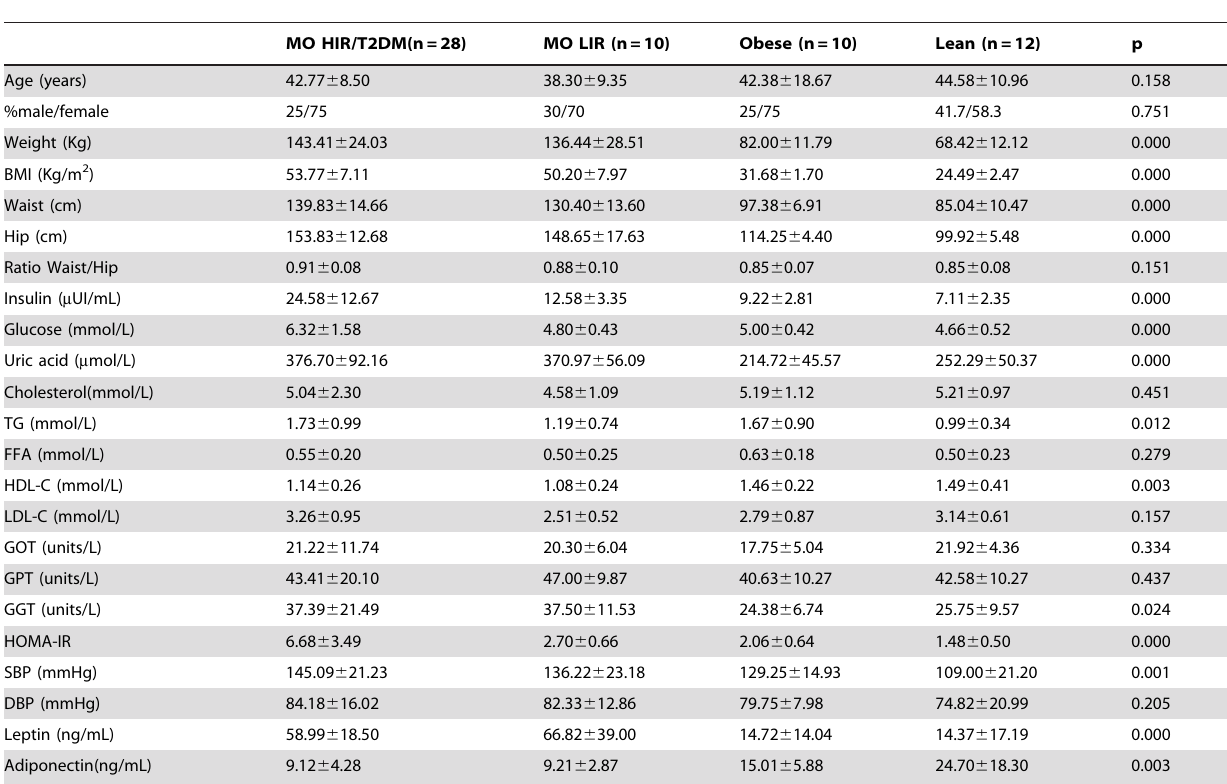
Table 1. Anthropometric and biochemical characteristics of the morbidly obese patients, and the obese and lean healthy subjects.